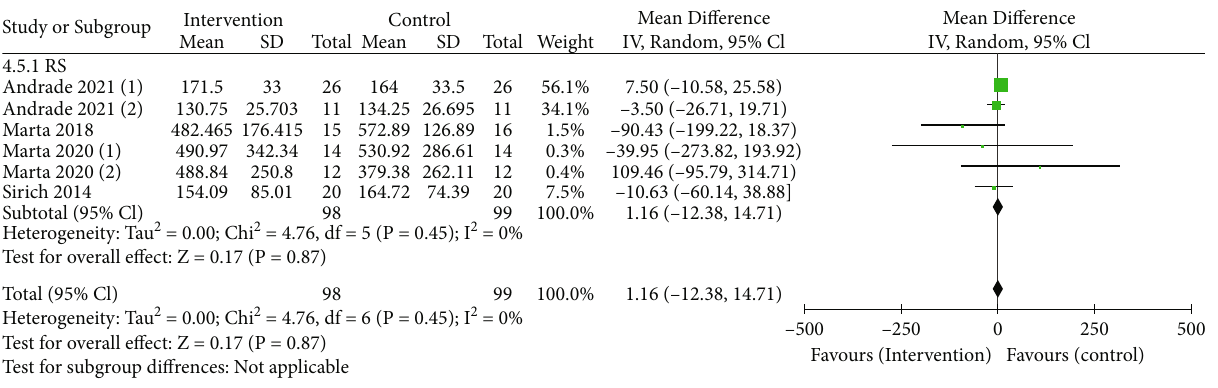
Figure 4: Pooled estimated e ff ect of RS intake on paracresol sulfate ( μ mol/L) in patients with CKD, with estimated MD and 95% CIs.